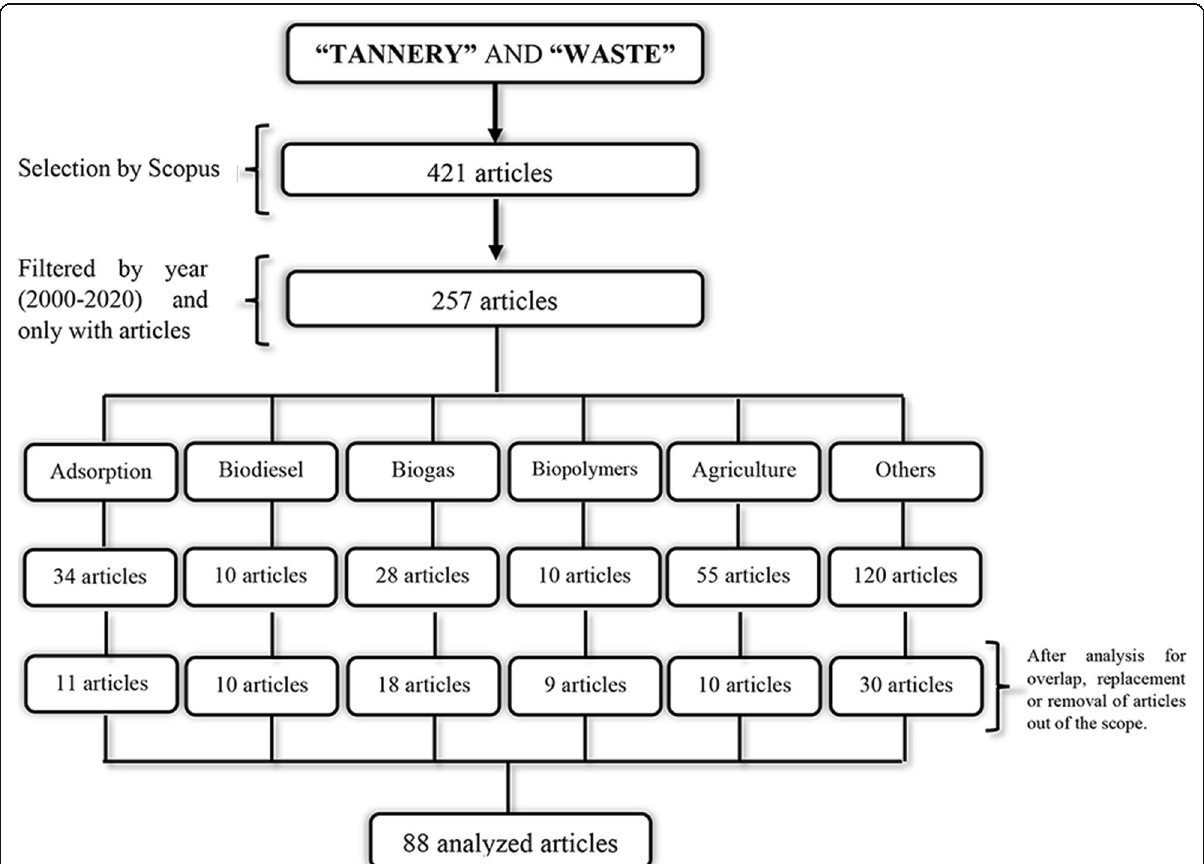
Fig. 1 Conditions established for the selection and analysis of articles within the scope of this